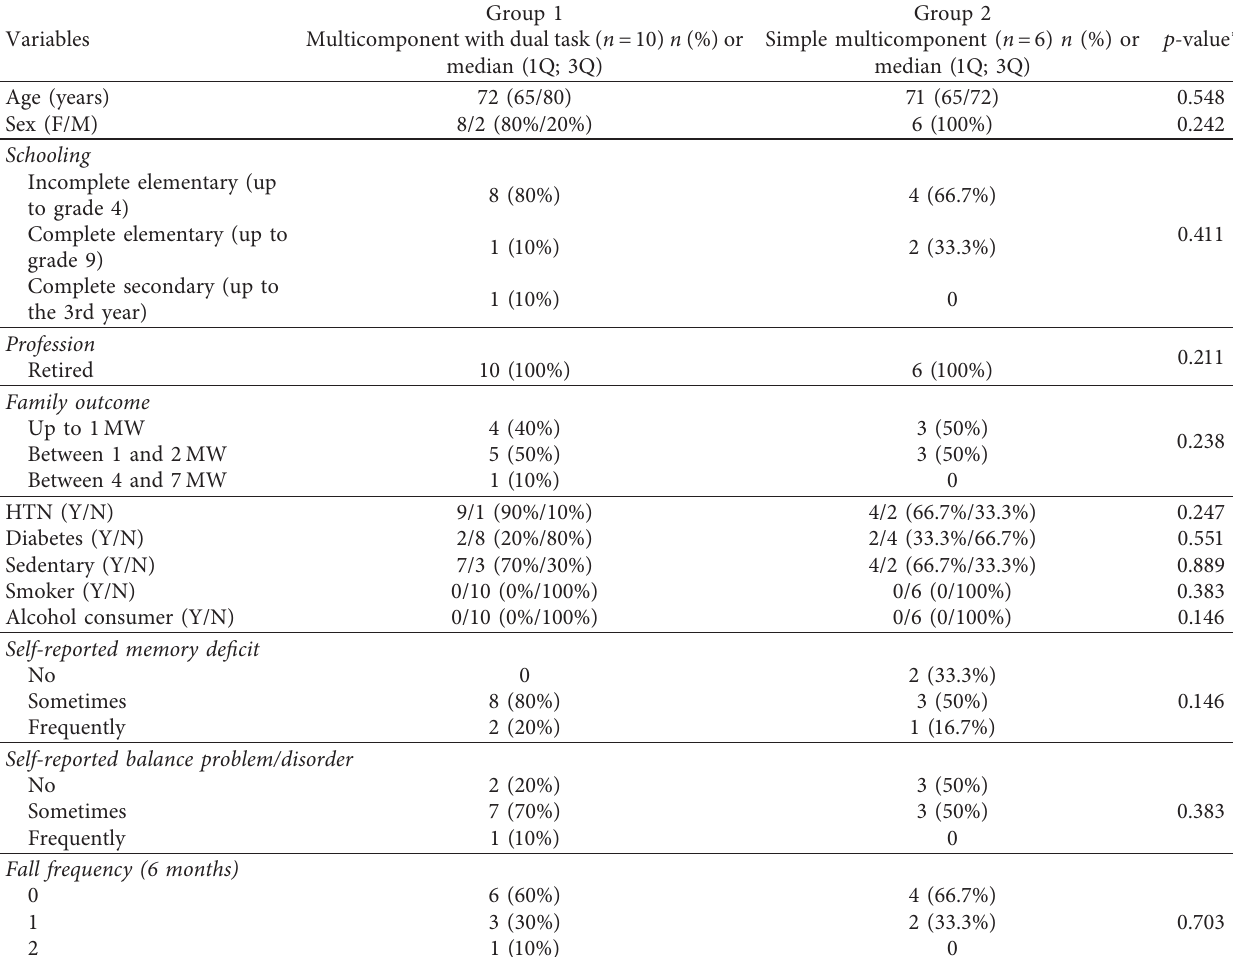
Table 3: Descriptive analysis of the sociodemographic profile of each